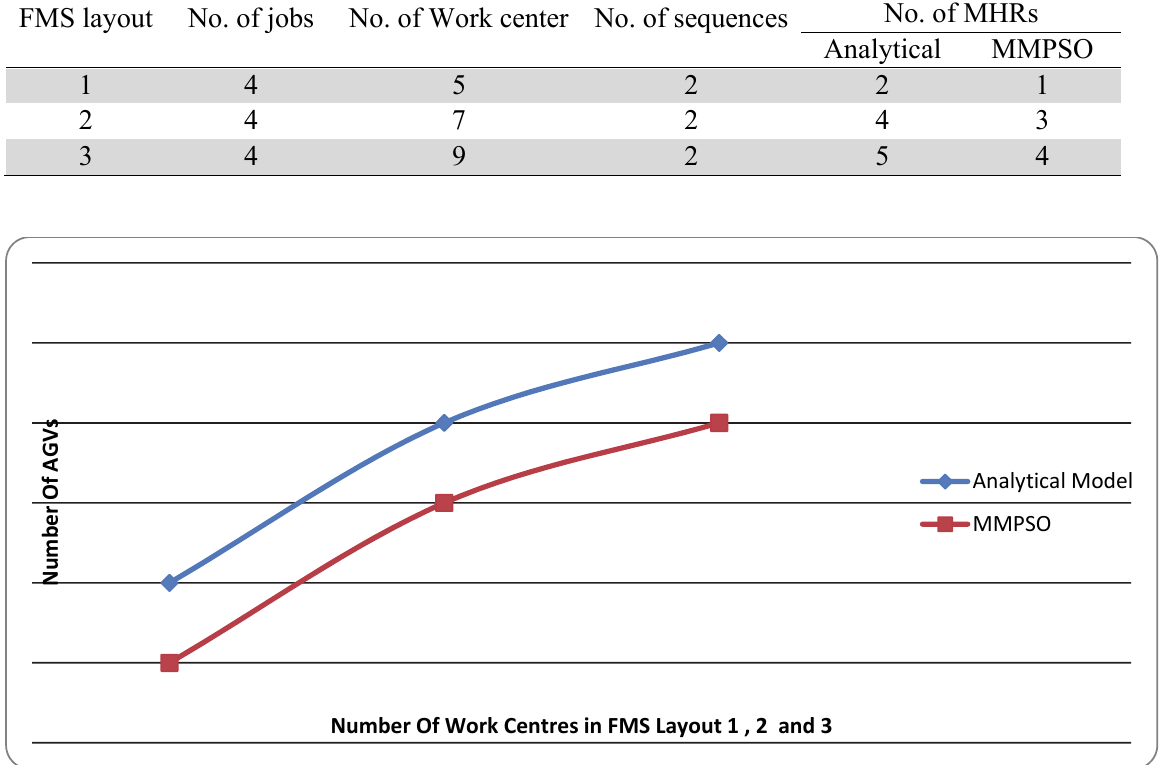
Fig. 5. Comparison of the MHR fleet size by the MMPSO algorithm and the analytical